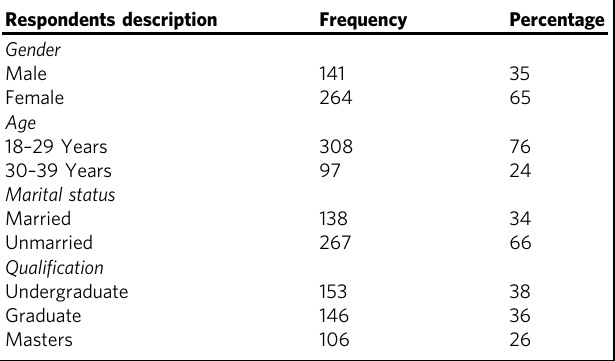
Table 1 Demographic Information of